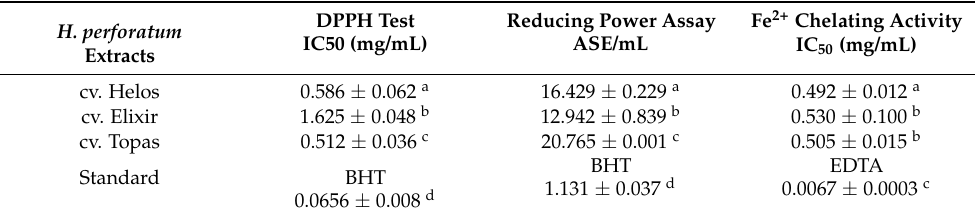
Table 2. Free radical scavenging activity (DPPH test), reducing power, ferrous ion (Fe 2+ ) chelat- ing activity of methanolic extracts obtained from the biomass of in vitro agitated cultures of the H. perforatum cultivars Helos, Elixir, and Topas (MS, 0.1 mg/L BAP and 0.1 mg/L NAA, 5